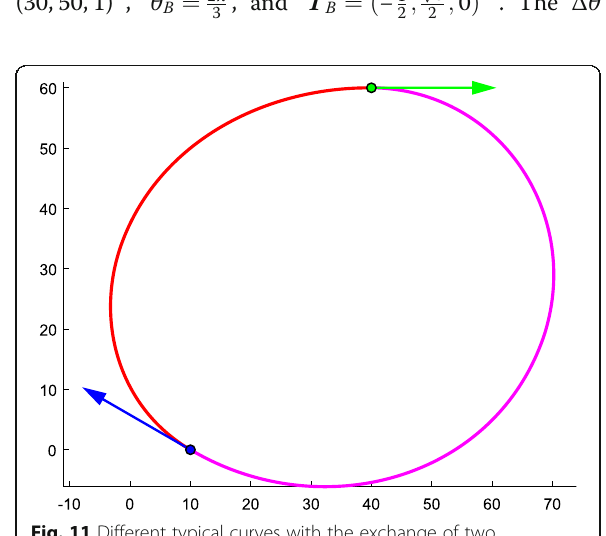
Fig. 11 Different typical curves with the exchange of two endpoint-orientation pairs